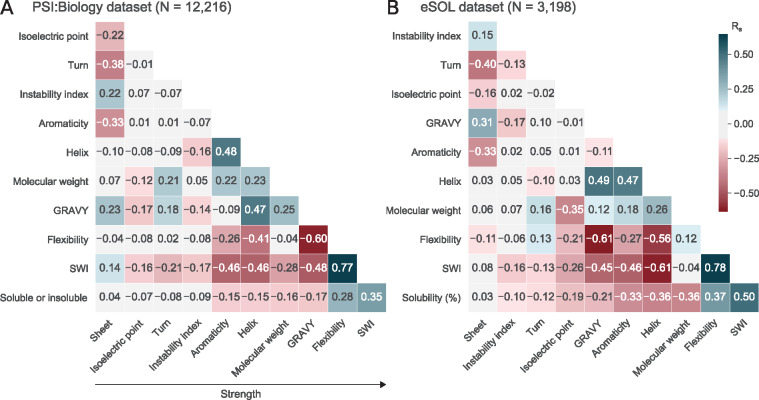
SWI strongly correlates with protein solubility. (A) Correlation matrix plot of the solubility of recombinant proteins expressed in E.coli and their standard protein sequence properties and SWI. These recombinant proteins are the PSI: Biology targets (N = 12 216) with a binary solubility status of ‘Protein_Soluble’ or ‘Tested_Not_Soluble’. Related data are available as Supplementary Table S5. (B) Correlation matrix plot of the solubility percentages of E.coli proteins and their standard protein sequence properties and SWI. The solubility percentages were previously determined using an E.coli cell-free system (eSOL, N = 3198). Related data are available as Supplementary Table S6. GRAVY, Grand Average of Hydropathy; PSI: Biology, Protein Structure Initiative: Biology; Rs, Spearman’s rho; SWI, Solubility-Weighted Index